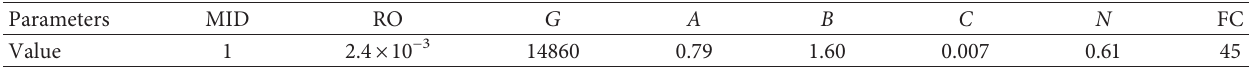
Table 3: Parameters of ∗ MAT_JOHNSON_HOLMGUIST_CONCRETE (card1).